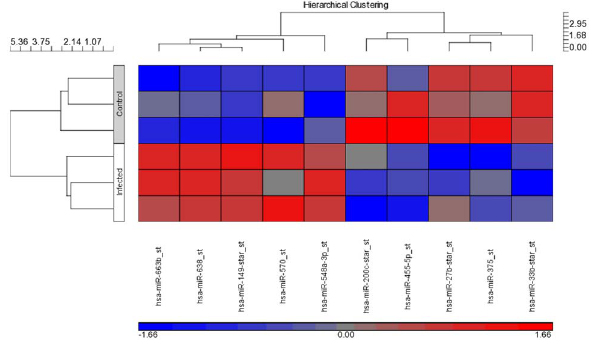
Figure 6. Heat map of differential expression of selected miRNAs by microarray. The two-way hierarchical cluster heat map showed differential expressed selected miRNAs of two groups of samples. The miRNAs from both methodology qPCR data showed similar direction of response in microarray analysis data with both methodologies showing similar trends where blue represents miRNAs with decreased expression and red represent miRNAs with increased